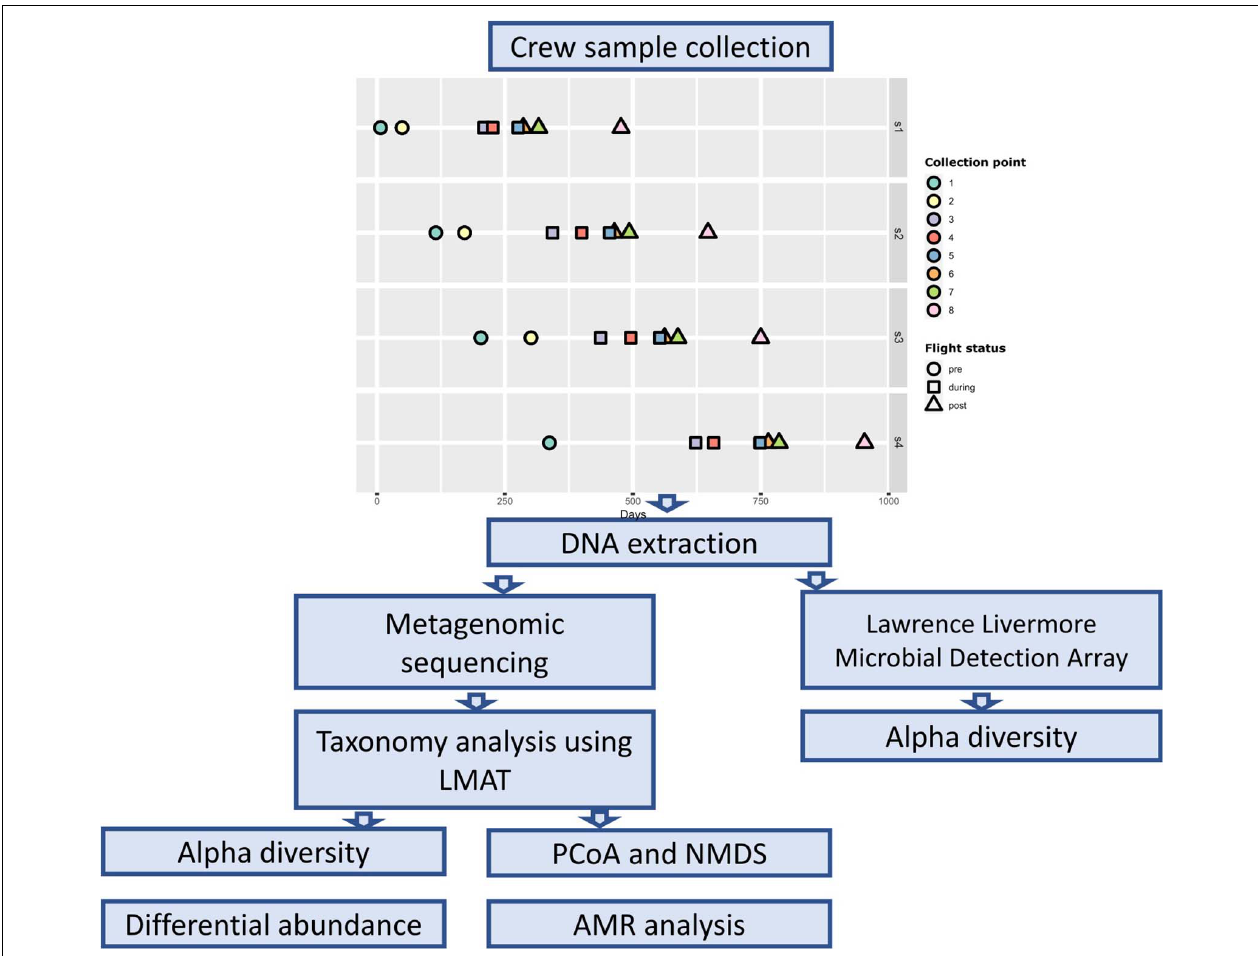
FIGURE 1 | Overall experimental and data analysis workflow and sample collection